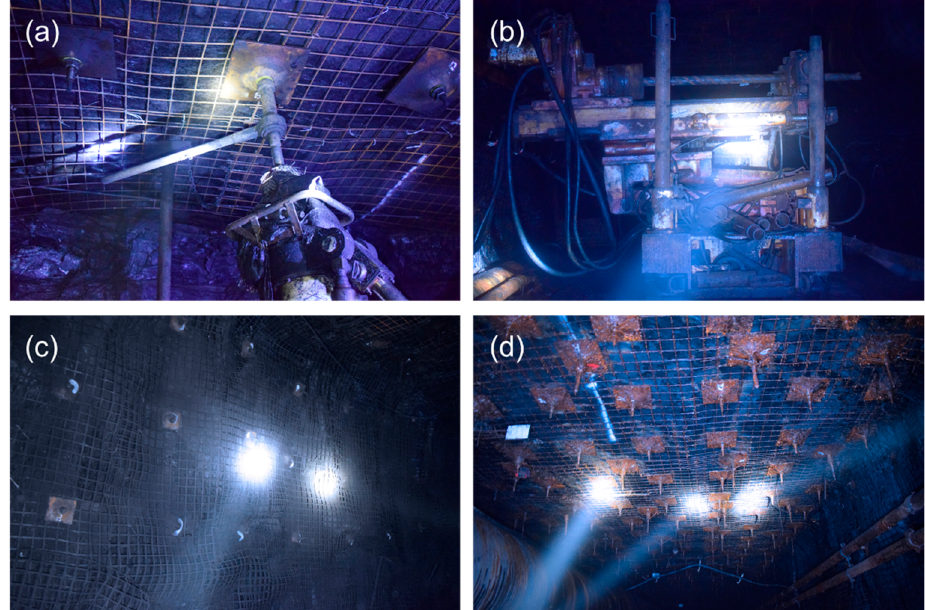
Figure 10. Field construction and tunnel maintenance effects: ( a ) torque amplifier preloading flexible bolt; ( b ) hydraulic pit drill construction blasting drilling; ( c ) maintenance effect of sides; and ( d ) maintenance effect of roof.